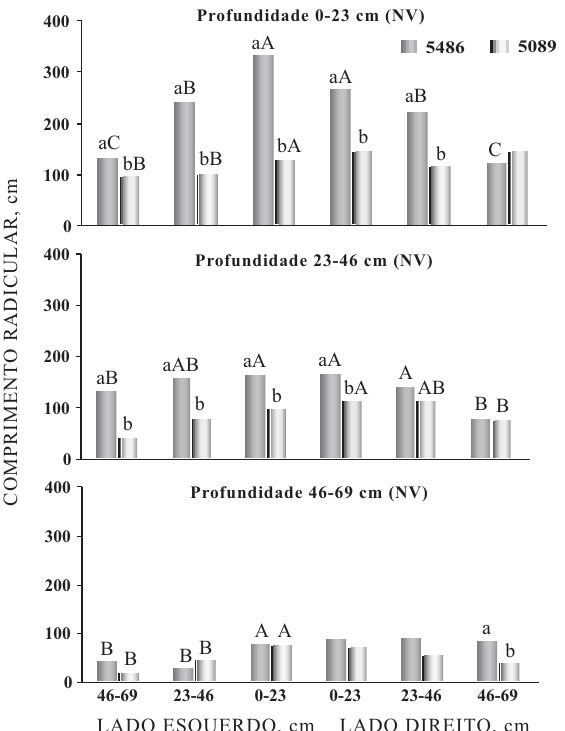
Figura 6. Comprimento radicular nos lados esquerdo e direito das linhas de cana-de-açúcar em três profundidades no NV. Letras minúsculas comparam cultivares dentro de cada distância horizontal. Letras maiúsculas comparam cada cultivar em relação às três distâncias horizontais. Diferença Mínima Significativa (DMS) a 5